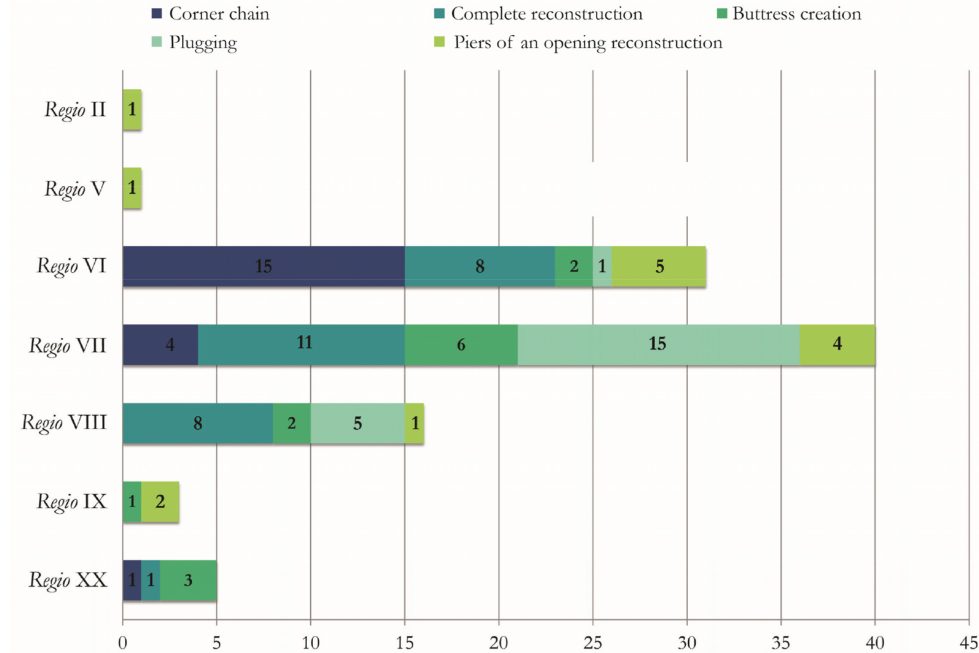
Figure 11. Graph of the distribution of the various types of repairs realized in NYT within the different Regiones